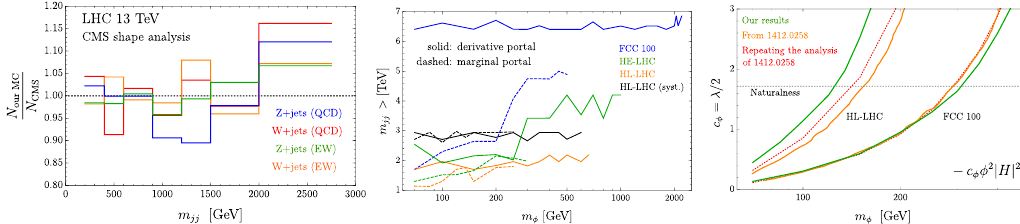
Figure 10: Left: comparison of our MC predictions to the expected yields in the CMS shape analysis (reported in Table 3 of Ref. [ 52 ] ). Each of our MC samples has been normalized to the total expected yield quoted by CMS. The required rescaling factors are 1.18,1.08 for Z νν ( QCD ) , W (cid:96)ν ( QCD ) , and 1.74,1.63 for Z νν ( EW ) , W (cid:96)ν ( EW ) . We ∈ [ 2.75,3.5 ] TeV and m > 3.5 TeV bins because there the do not show the m jj jj statistical uncertainty of our MC is large. Middle: summary of the optimized m jj cut we adopt at hadron colliders. For the HL-LHC with 1% systematic uncertainty we > 3 TeV as the strongest possible cut, due to the limited MC statistics. Right: take m jj comparison of our results for the marginal portal at hadron colliders with those of Ref. [ 48 ] . See text for further